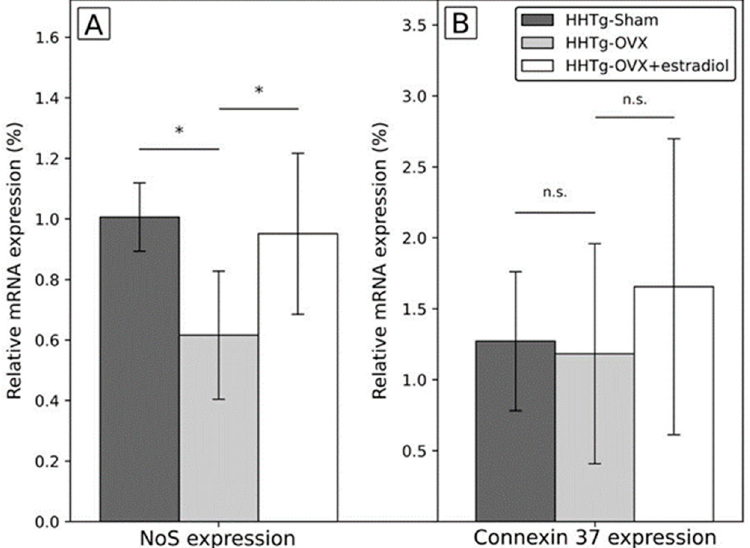
Figure 2. Differences in the expression of genes in abdominal aorta after ovariectomy and estradiol substitution in HHTg rats. Legend: HHTg: hereditary hypetriglyceridemic; HHTg-Sham: sham group, n = 5; HHTg-OVX: Ovx: ovariectomy ( n = 6); HHTg-OVX + estradiol: ovariectomy followed by estradiol substitution ( n = 6). ( A ) NoS expression: expression of the gene for nitric oxid synthase , ( B ) Connexin 37 expression: expression of the gene for connexin 37 . Data are expressed as mean ± SD and evaluated by one-way ANOVA and Fisher LSD post-hoc test; n.s.: nonsignificant, * p < 0.05.